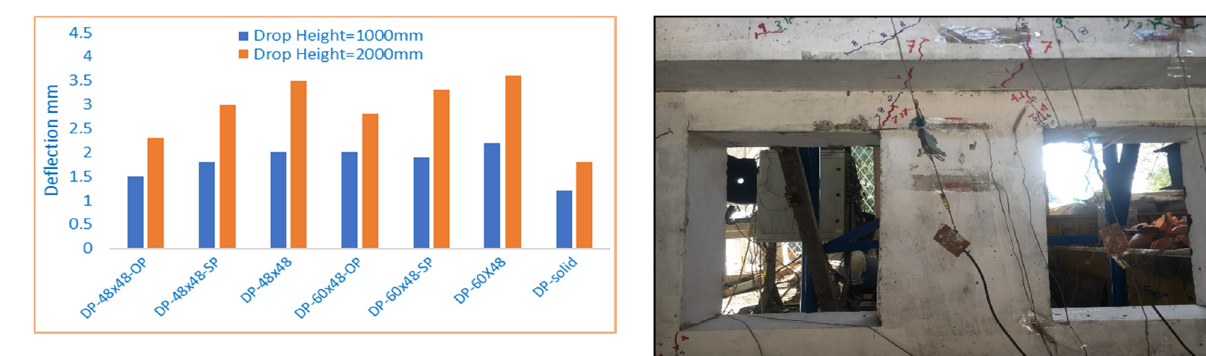
Figure 10: Summary of maximum mid span de fl ections due to impact load.